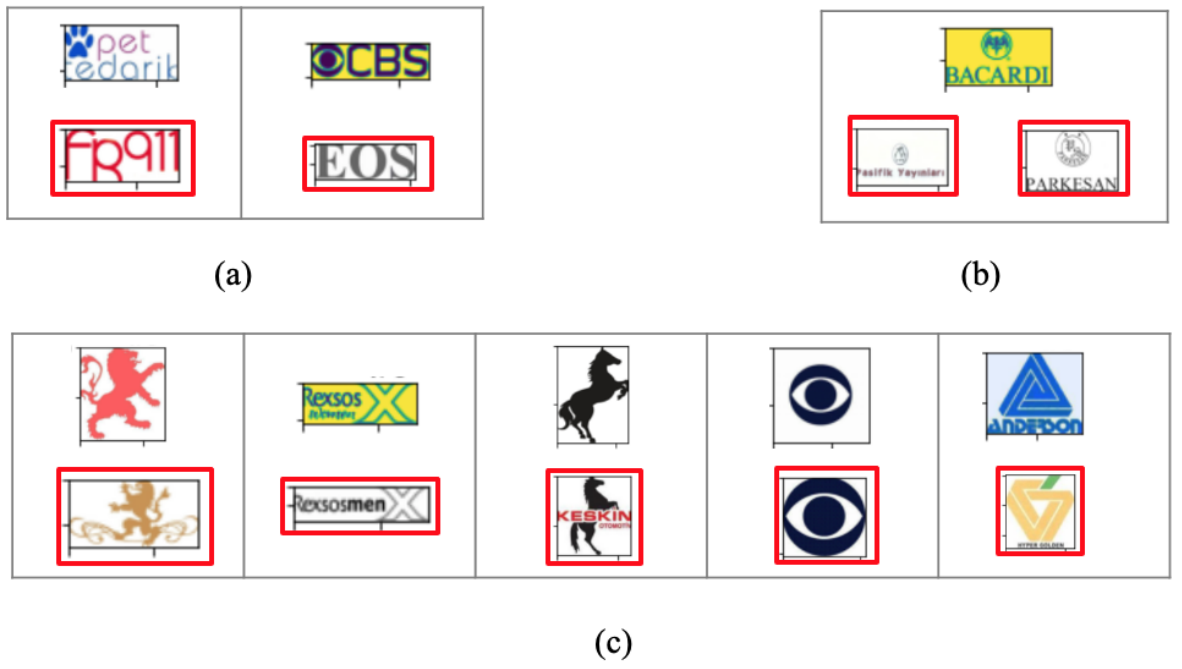
Figure 5. Examples of samples retrieved from the test set (in red rectangles), with a related query: ( a ) Trademark containing text. ( b ) Trademarks have the same arrangement of objects. ( c ) Similar retrieved images.